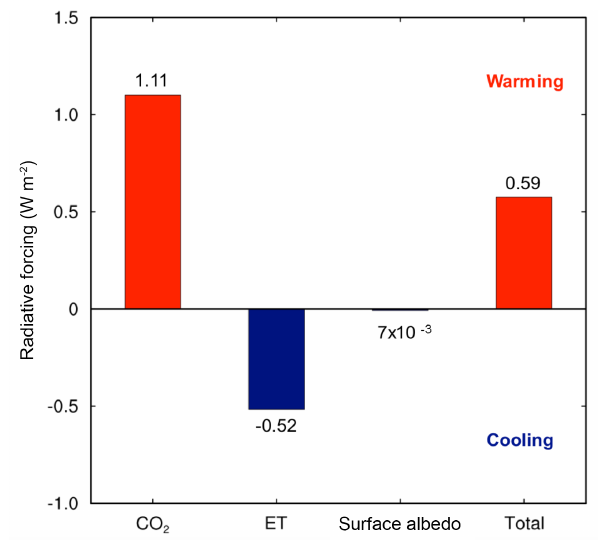
Figure 2. The impacts of the C cost of symbiont-mediated N acqui- sition led to a net increase in global radiative forcing. The warming due to increasing atmospheric CO 2 was offset partially by cooling due to reduced evapotranspiration (ET) and surface albedo. These results were obtained from CAM runs with and without the sym- biont sub-module (CLM-FUN) and represent the mean of the last 10 years of the simulation from 1995 to